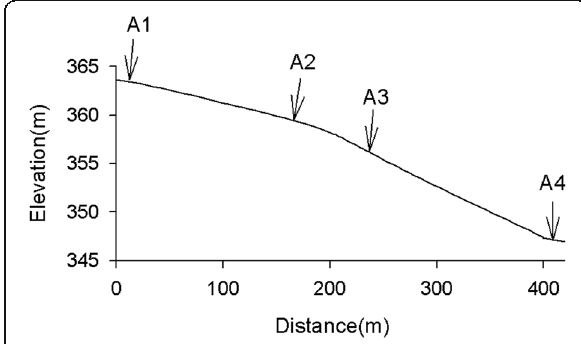
Fig. 1 Topographical transects and sampling point locations for the study site. A1: non-eroding profile, A2 and A3: eroding profiles, A4: depositional